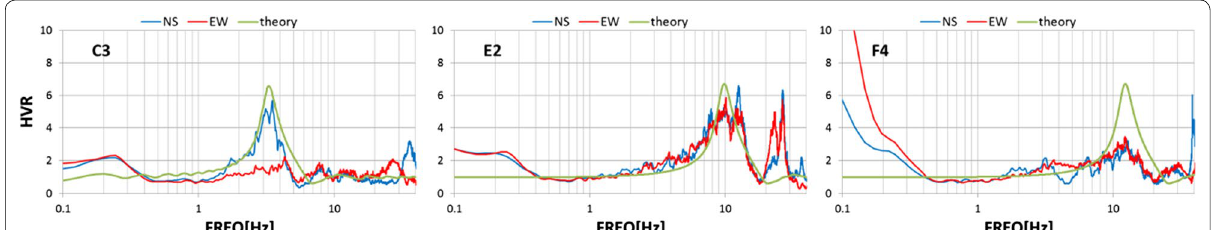
Fig. 12 Comparison of the observed MHVRs ( blue and red lines ) with the analytical MHVRs ( green line ) for points C3, E2 and F4. The peak frequency and peak amplitude fit the NS/UD at point C3, both components at point E2 and the peak frequency at point F4